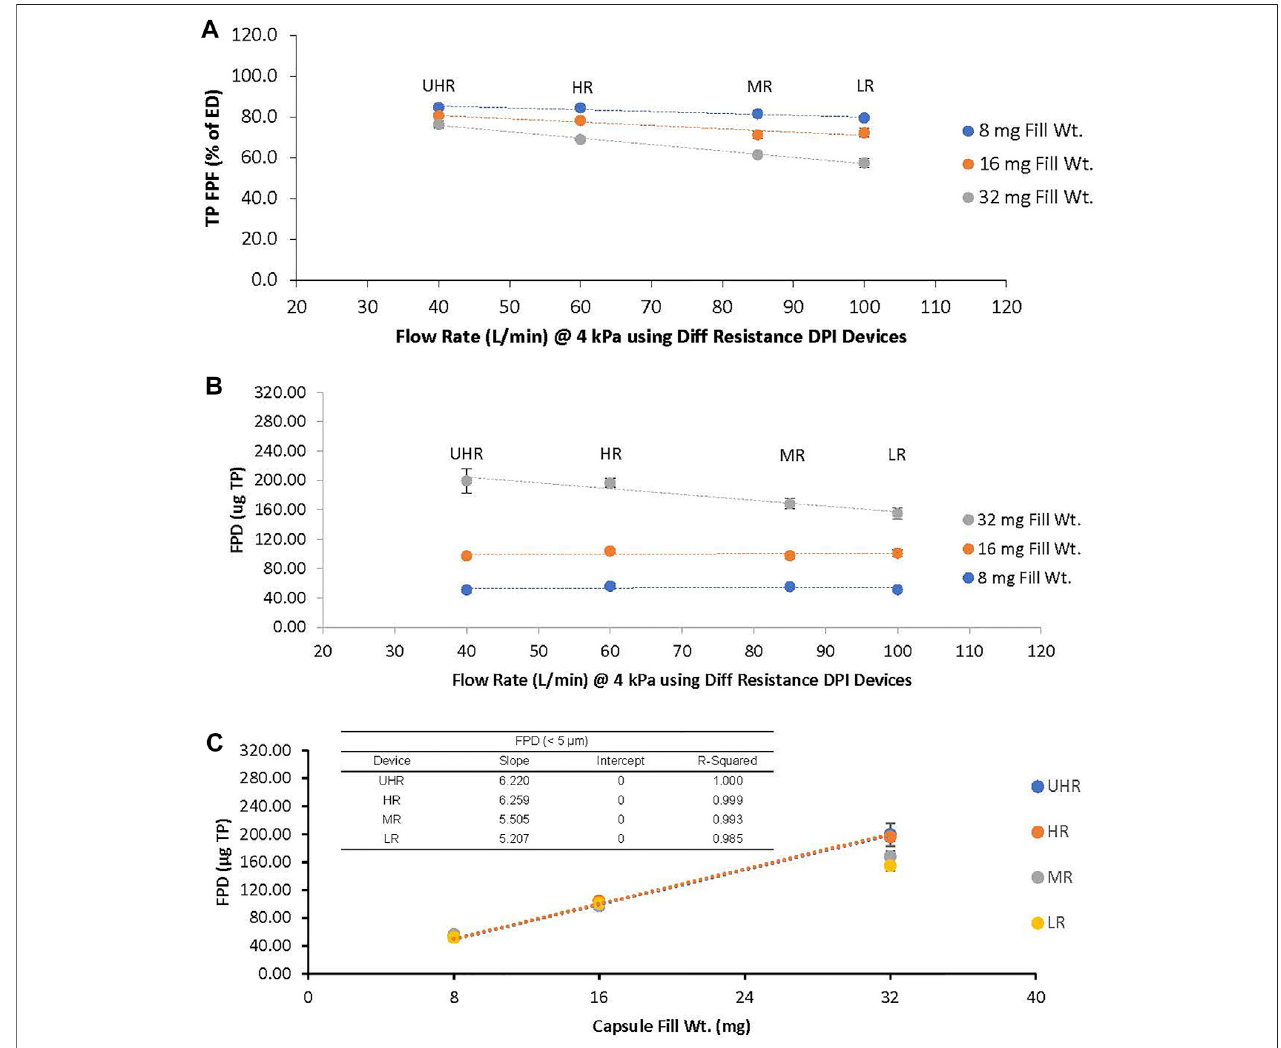
FIGURE 3 | (A) : TP Fine Particle Fraction (FPF) and (B) : TP Fine Particle Dose (FPD) as a Function of Device Resistance for the 8 mg (blue), 16 mg (orange), and 32 mg (gray) Capsule Dose. (C) : TP FPD as a Function of Capsule Dose for Each Device. Trend lines are only shown for the UHR and HR DPIs in 3c. The ultra-high resistance (UHR), the high resistance (HR), the medium resistance (MR) and the low resistance (LR) devices were tested at 40, 60, 85 and 100 LPM, respectively.